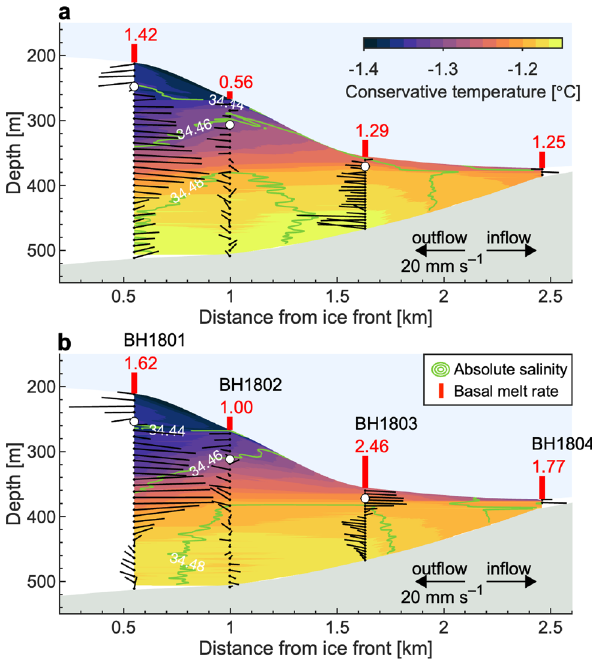
Fig. 4 Overview of thermohaline structure and circulation. Water current, conservative temperature, and absolute salinity measured in the ice shelf cavity of Langhovde Glacier in January 2018. Measurements were performed twice at each borehole site in ( a ) high and ( b ) low tides. The length and orientation of black lines indicate current speed and direction. Cross-glacier components of the current speed are projected to the vertical: leftward-looking — fl ow to the open ocean, rightward-looking — fl ow to the grounding zone, upward-looking — fl ow to the northeast, and downward- looking — fl ow to the southwest of the cavity on the plane view (Fig. 1b). Background shows the vertical cross sections of conservative temperature (color scale) and absolute salinity (green contour line). Estimated basal met rates (m a − 1 ) are indicted by red bars and numbers. Open circles indicate the lower boundary of the ice – ocean boundary layer.